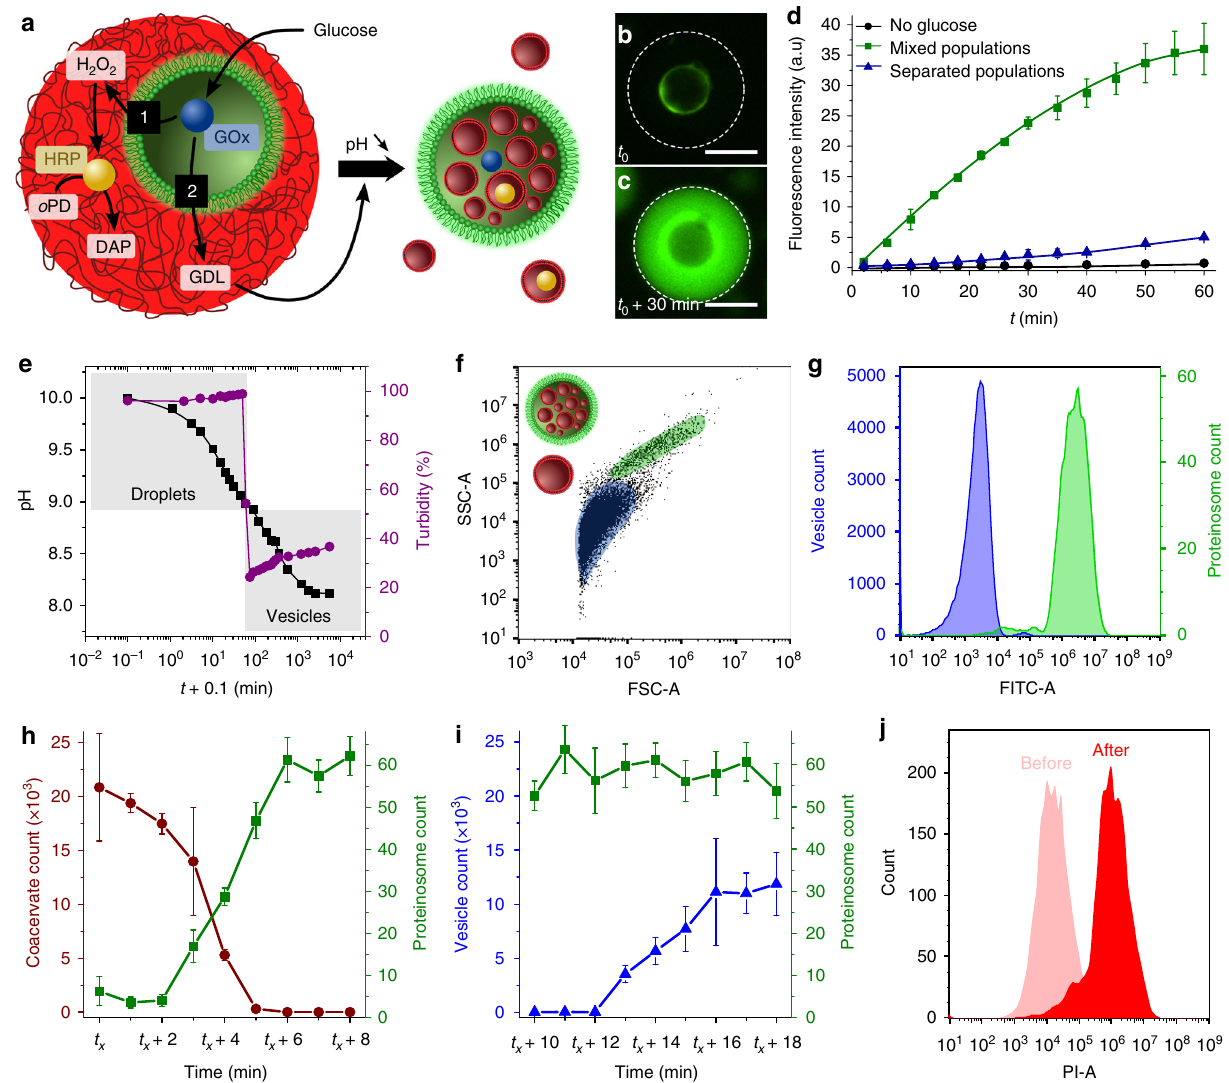
Fig. 2 Synergistic and antagonistic behaviour in synthetic host – guest protocells. a Graphic showing FITC-labelled proteinosome (green) containing GOx (blue circle) internalised by a single pH-responsive fatty acid micelle coacervate droplet (red) loaded with horseradish peroxidase (HRP, yellow circle) to form a nested proteinosome-in-coacervate structure capable of synergistic (path 1) or antagonistic (path 2) chemical coupling. o PD ortho - phenylenediamine; DAP 2,3-diaminophenazine; GDL glucono- δ -lactone. b , c Fluorescence microscopy images showing a single proteinosome-in- coacervate protocell immediately after addition of glucose (1 mM, t 0 ) ( b ), and after 30 min reaction time ( c ). d Time-dependent changes in fl uorescence intensity associated with the formation of DAP in host – guest protocells produced as described in a (green squares), or in spatially separated protocell populations in the presence (blue triangles) or absence (control; black dots) of 1 mM glucose (see Methods). Error bars represent the standard deviation of the fl uorescence intensity ( n = 3). e Time-dependent plot showing gradual decrease in pH (black squares) and associated rapid decrease in turbidity (purple circles) due to vesicle formation at pH 8.9 for a population of GOx-containing proteinosome-in-micelle coacervate protocells (number density ratio = 1:12) incubated in glucose ( t = 0, 10 mM). f FACS-derived 2D dot plots recorded 120 min after addition of glucose (10 mM) to a suspension of FITC- labelled GOx-containing proteinosome-in-coacervate host – guest protocells (number density ratio = 1:12) showing coexistence of a binary population of free myristic acid vesicles (blue domain) and proteinosomes containing fatty acid vesicles (green domain). FSC forward-scattered light; SSC side-scattered light. g Histograms of green fl uorescence signals (FITC-A) recorded 120 min after addition of 10 mM glucose to FITC-labelled GOx-containing proteinosome-in-coacervate protocells; plots for unlabelled myristic acid vesicles dispersed in the bulk phase (blue, low fl uorescence) and proteinosomes containing fatty acid vesicles (green, high fl uorescence) are shown. h Plots showing population dynamics associated with the disassembly of GOx- containing FITC-labelled proteinosome-in-micelle coacervate droplets (red, number ratio = 1:12) and release of the entrapped proteinosomes (green). Counts were determined from the FACS-derived 2D dot plots, averaged every 5 s, and the standard deviation calculated accordingly. i Plots as derived in h but recorded over a period of 10 min and beginning from t x + 10 min showing constant and increasing vesicle-in-proteinosome (green) and free vesicle (blue) populations, respectively. j FACS-derived red fl uorescence intensity (PI-A) histograms determined from proteinosome-gated 2D dot plots recorded on a single GOx-containing, non-labelled proteinosome population before mixing with Nile Red-stained micelle coacervate droplets, and 120 min after addition of 10 mM glucose to a dispersion of GOx-containing proteinosome-in-coacervate